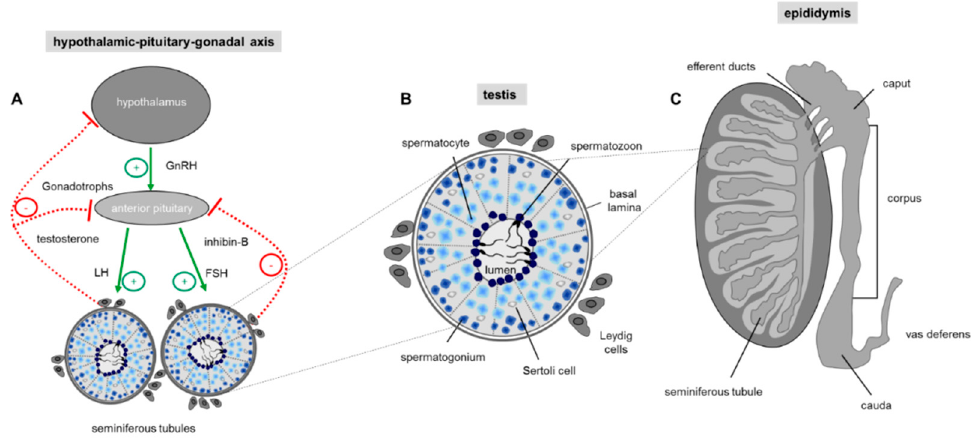
Figure 2. Regulation of sperm production. ( A ) Hormonal control of spermatogenesis in the testis. Spermatogenesis in the testis is under endocrine and paracrine control, which is regulated by the hypothalamus and the pituitary gland also known as hypothalamic-pituitary-gonadal (HPG) axis. The hypothalamus regulates the hormonal activity of the anterior pituitary gland by secreting the tropic gonadotropin-releasing hormone (GnRH). Upon binding of GnRH to the anterior pituitary gland production of luteinizing hormone (LH) and follicle stimulating hormone (FSH) is elevated which upon blood stream transport stimulate testosterone secretion by intestinal Leydig cells and activation of Sertoli cells by FSH. Sertoli cells as cellular part of the tubular unit provide the optimal environment for the developing germ cells. A negative feedback of GnRH production in the hypothalamic neurons and LH/FSH secretion by the pituitary gland is exerted by high testosterone levels in the blood and secretion of the proteohormone inhibin-B by Sertoli cells. Arrow: positive (green) and negative (red) feedback. ( B ) Schematic drawing of a single seminiferous tubule with different stages of developing germ cells during spermatogenesis. The cross section shows that germ cells of a distinct developmental stage are organized in concentric layers within the tubule: In the most basal cell layer of the tubular unit, the immature spermatogonial stem cells are located, followed by spermatocytes, round spermatids and finally the most mature elongated spermatids which are concentrated in the lumen of the seminiferous tubule. The regulation of spermatogenesis is mainly mediated by surrounding interstitial Leydig cells which produce testosterone. The Sertoli cells within the seminiferous tubules have a nurturing role for the developing germ cell and transduce the action of FSH to the closely associated germ cells. ( C ) Schematic drawing showing a sagittal section through a whole testis and the overlying epididymis. The testis contains the tightly packed seminiferous tubules where spermatogenesis takes place. The elongated duct presenting the epididymis at the posterior margin of the testis is subdivided into three discrete segments (caput, corpus, cauda), where the luminal fluid of each region is characterized by a unique composition of different constituents, essential for post-testicular sperm maturation.